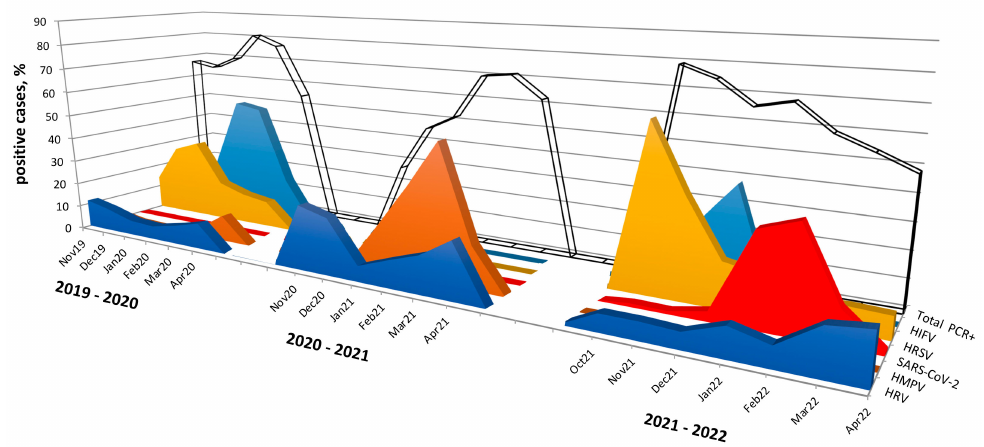
Figure 3. Most common acute respiratory virus fluctuations during 2019–2022. “Total PCR+” refers to the data that are presented as a percentage of the positive cases of PCR-confirmed samples from patients during the three research periods (2019–2022); HIFV—influenza A and B viruses; HRSV—respiratory syncytial virus; SARS-CoV-2—severe acute respiratory syndrome coronavirus 2, HMPV—metapneumovirus; and